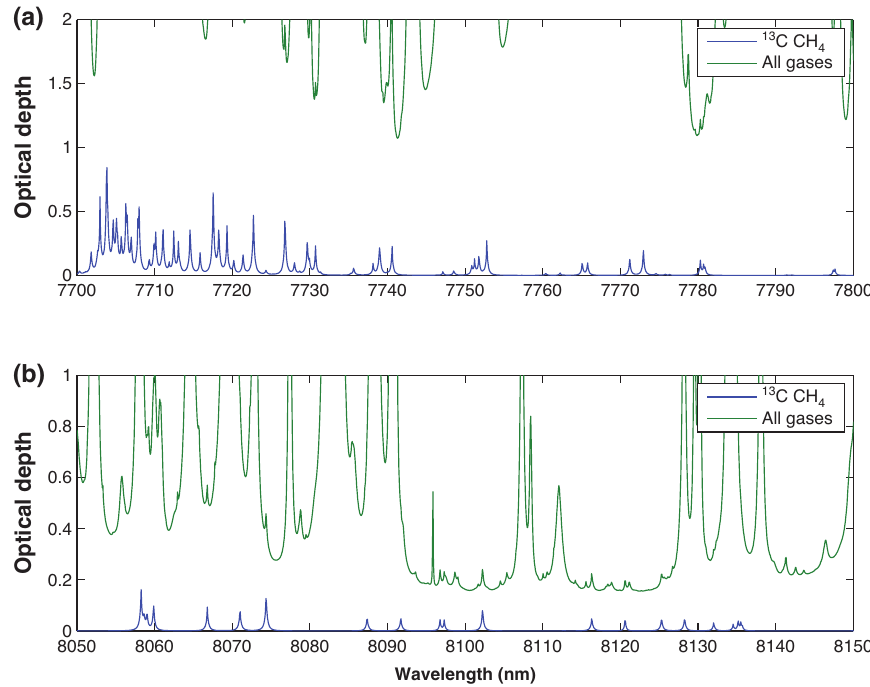
wavelength ranges 7700–7800 nm and 8050–8150